Question: What does this figure show? Answer in one sentence.
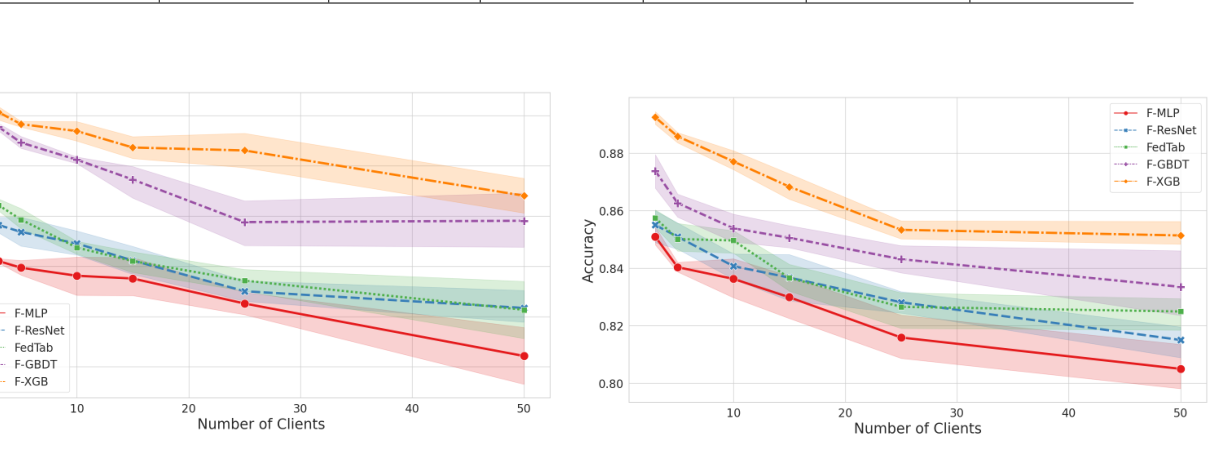
Answer: Models’ test accuracy for 3, 5, 10, 15, 25 and 50 clients on Adult dataset in homogeneous setting.